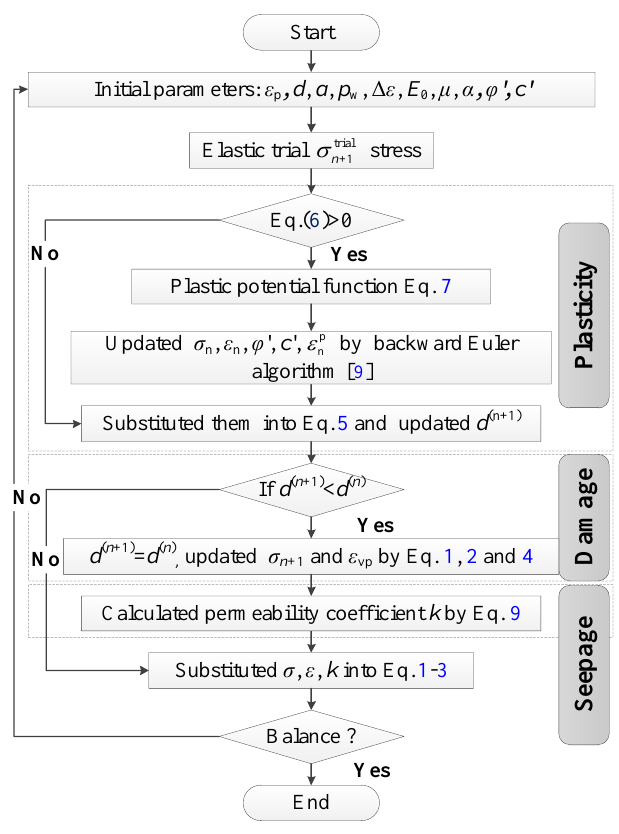
Figure 8. Numerical calculation process of PD-S model.